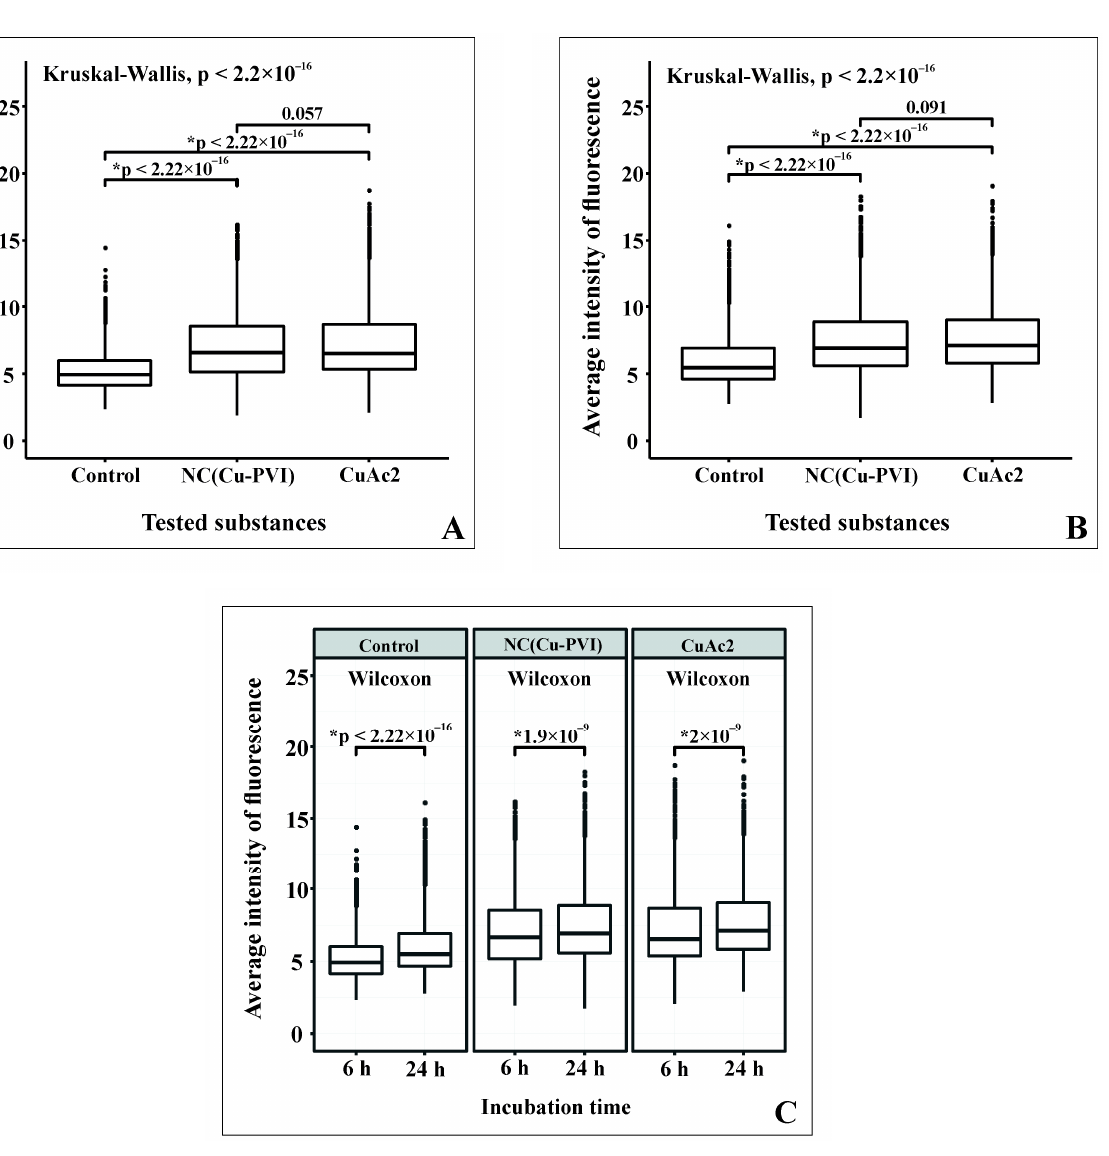
Figure 9. Changes in the cytochrome c oxidase fluorescent stain intensity in the hepatocyte culture after 6 h ( A ) and 24 h ( B ) of incubation with the NC(Cu-PVI) or CuAc 2 in comparison with the control group and depending on the duration of incubation ( C ). Medians and first and third quartiles are shown. * Differences are considered significant at p < 0.05.